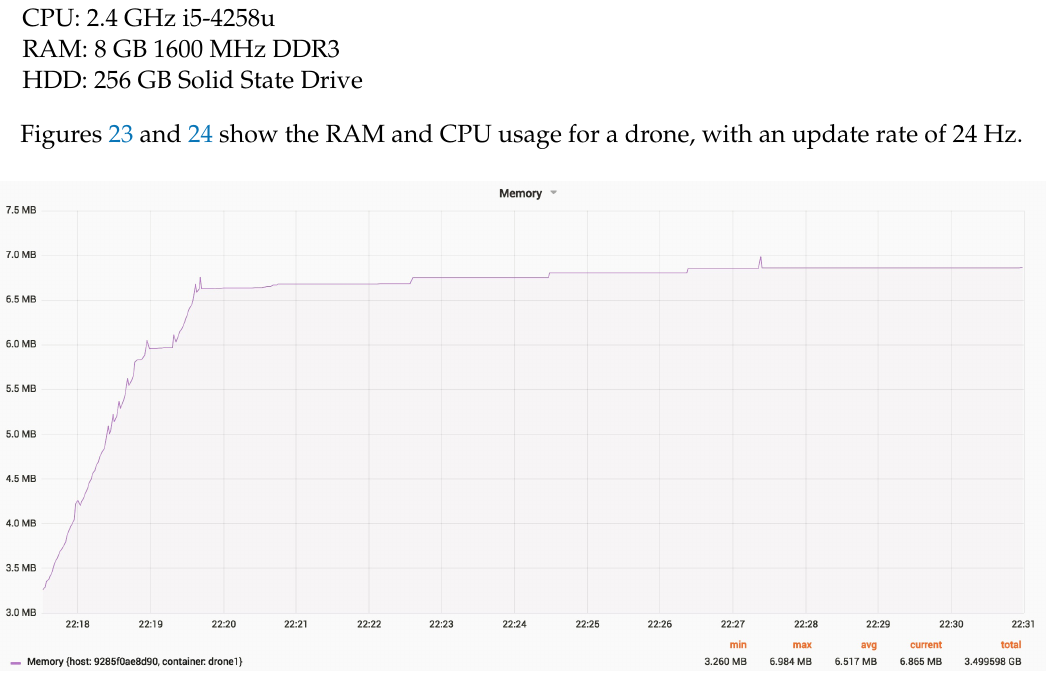
Figure 23. RAM usage for a